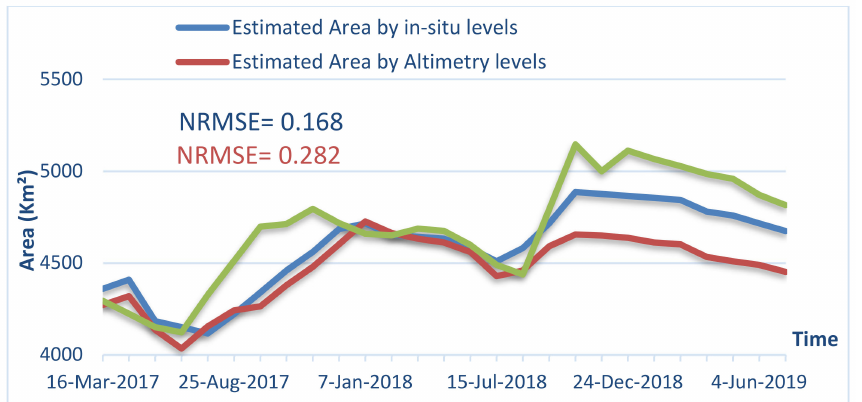
Figure 12. Estimated surface area of the AHDL over the period between 2016 and 2019, surface area estimated by the in-situ level and altimetry level as input of the model, and surface area estimated by unsupervised method in Section